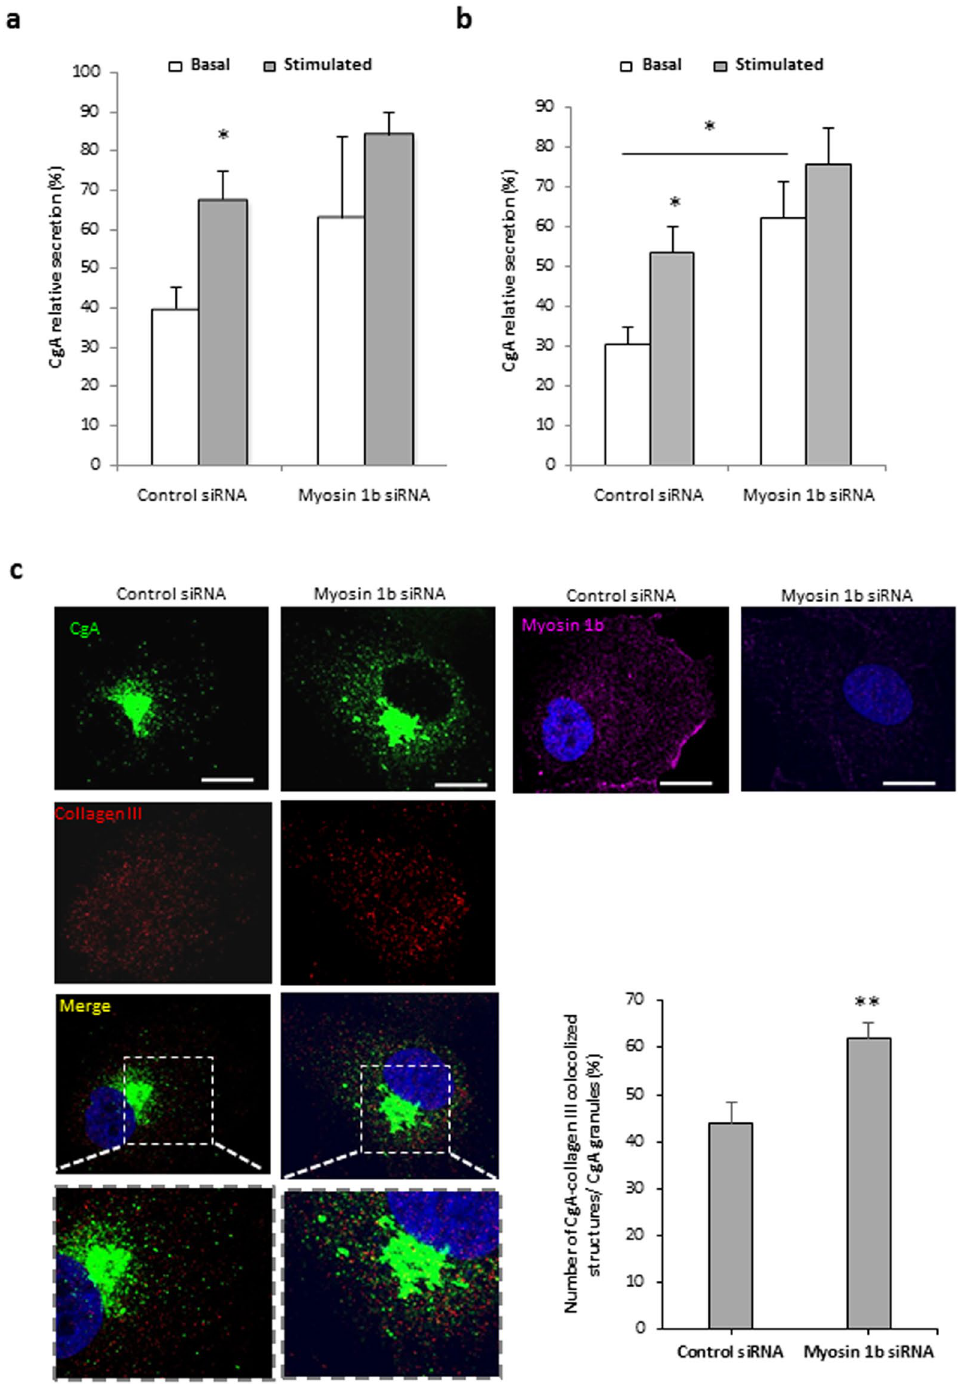
Figure 4. Myosin 1b depletion leads to CgA leakage through the constitutive secretory pathway. Quantification after Western blot analysis of CgA secretion and content from COS7-CgA cells ( a ) and PC12 cells ( b ), transfected with control or myo1b siRNA, in basal or 2 mM Ba 2 + -stimulated conditions. Normalized CgA release in the medium relative to total CgA (medium + cell content) is determined. The values represent the means ± s.e.m. from four independent experiments. * P < 0.05 (Mann-Whitney test). ( c ) COS7 cells were transfected with control siRNA or Myo1b siRNA and with a plasmid encoding CgA-GFP, fixed, immunolabeled with anti-collagen III or Myo1b antibody, and the distribution of CgA was analyzed by confocal microscopy. The scale bar represents 10 µ m. The number of CgA-GFP/collagen III colocalized structures in COS7-CgA cells, transfected with control or myosin 1b siRNAs, was quantified and expressed as percentages of CgA/collagen III colocalized structures relative to total CgA granules. The values represent the means ± s.e.m. from three independent experiments (n = 45 cells). ** P < 0.01 (Student’s t-test with Welch’s